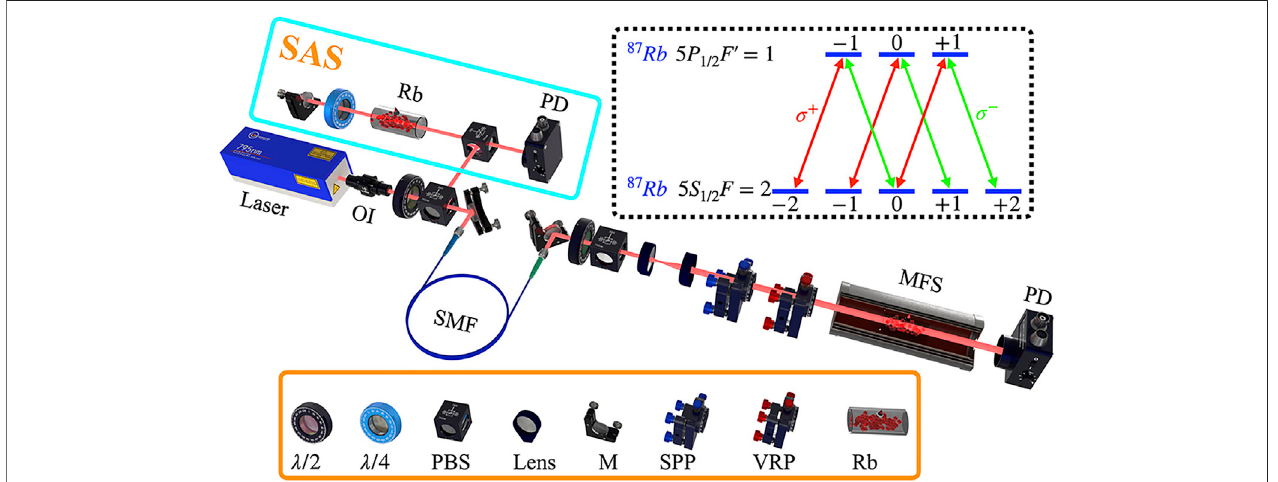
FIGURE 1 | Schematic of the experimental setup and atomic energy levels. HWP: half-wave plate; QWP: quarter-wave plate; PBS: polarization beam splitter; M: mirror; SPP: spiral phase plate; VRP: vortex retarder plate; OI: optics isolator; SMF: single-mode fi ber; MFS: magnetic fi eld shielding; PD: photo-detector; Rb: rubidium vapor; SAS: saturated absorption spectroscopy.